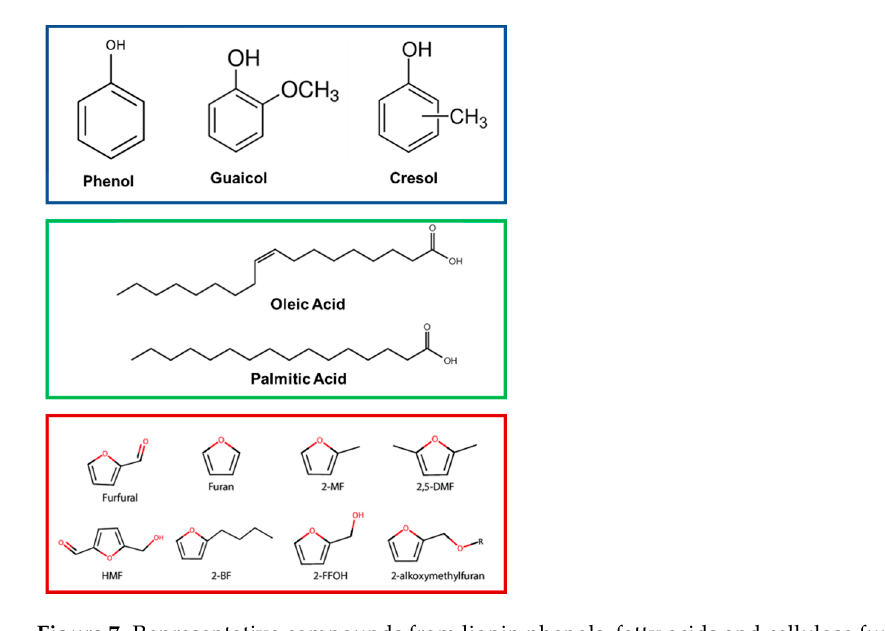
Figure 7. Representative compounds from lignin phenols, fatty acids and cellulose furans.